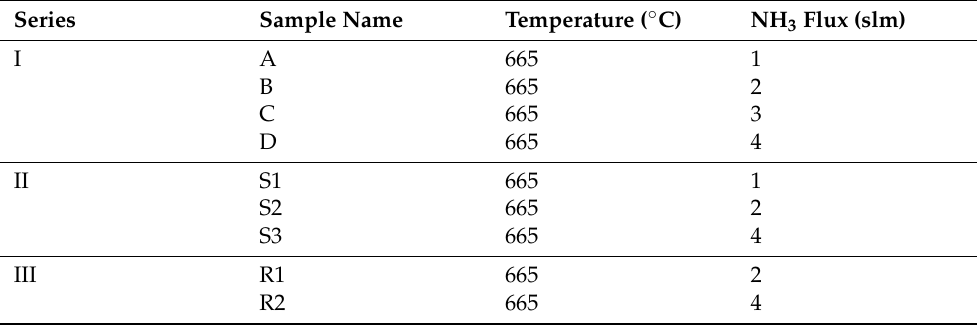
Table 1. Quantum well growth conditions for different samples of series I, II, and III with varying ammonia flow rates.